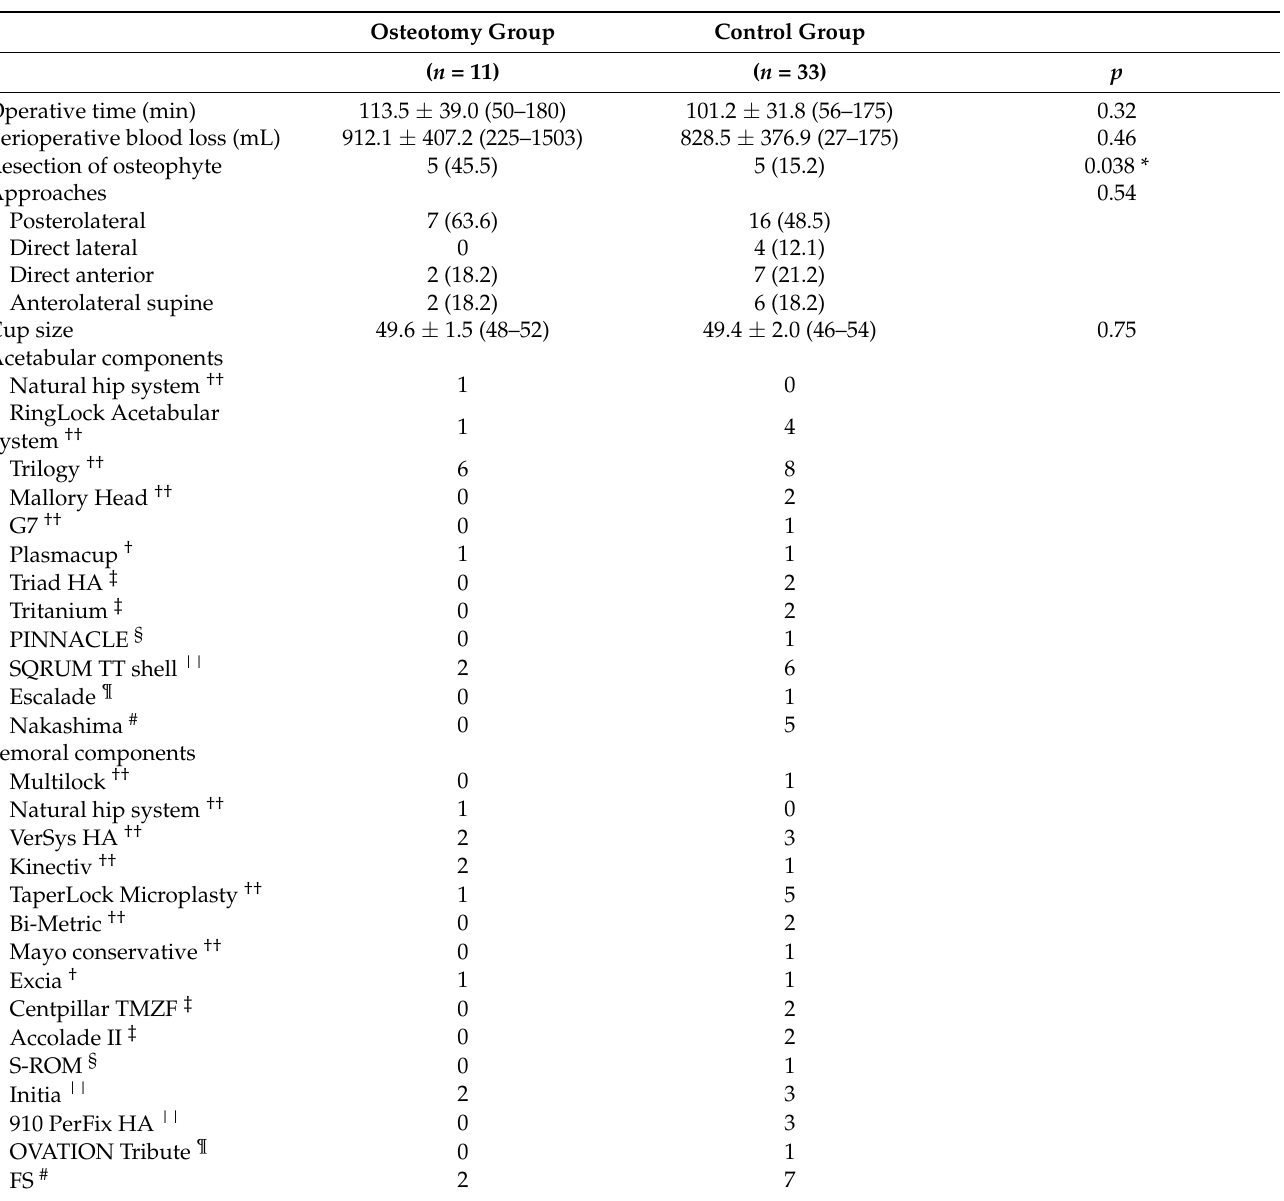
Table 1. Surgical